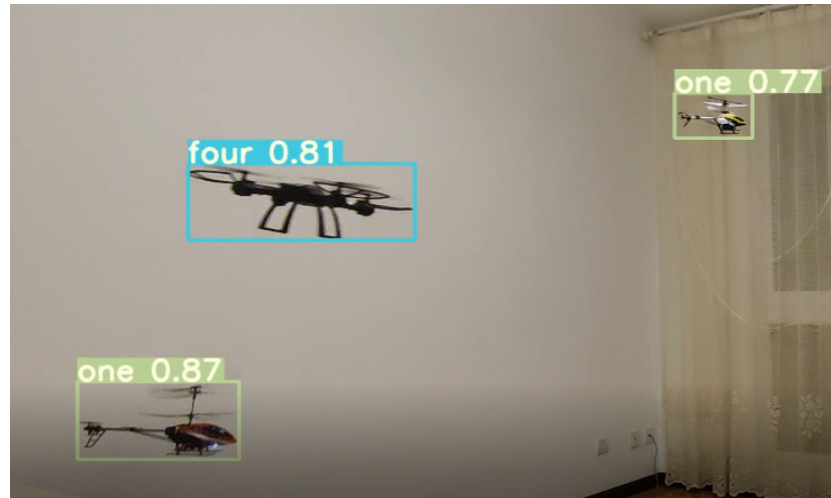
Figure 10. Detection effect in GPU environment.